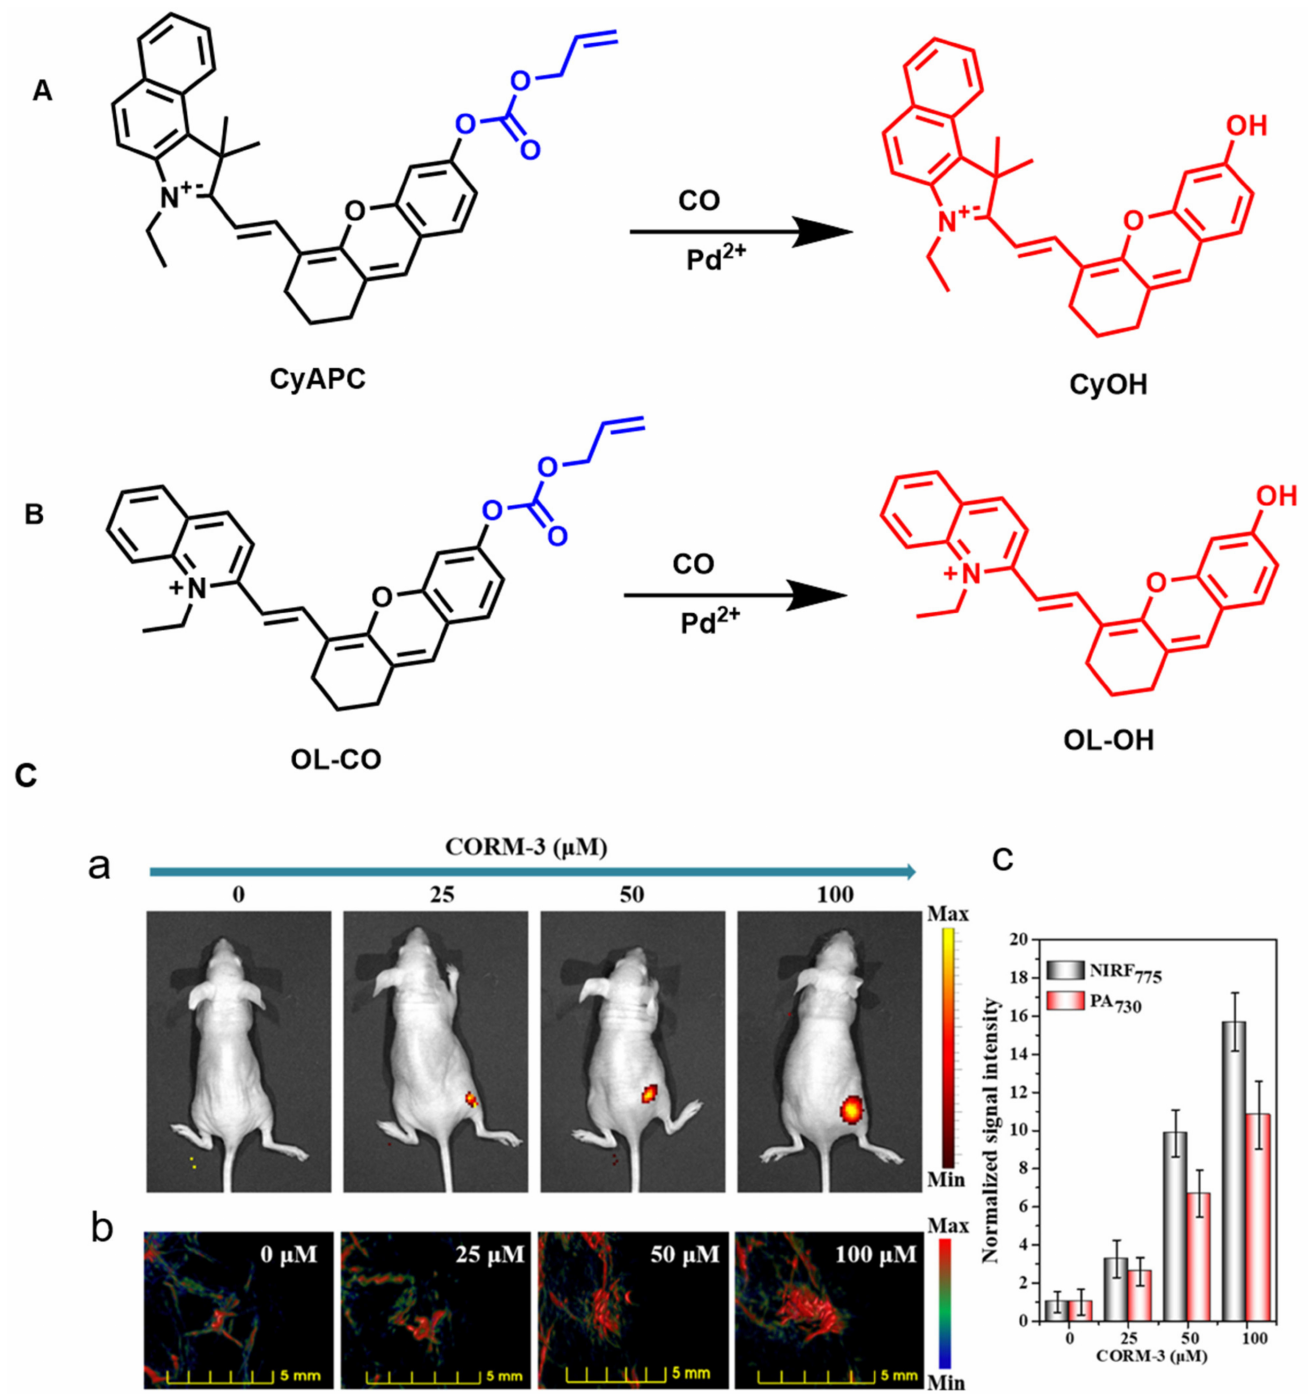
Figure 15. The response mechanisms and chemical structures ( A ) CyAPC and ( B ) OL-CO of fluores- cent probes for CO. ( C ) In vivo imaging of CO in living mice. ( a ) Fluorescent imaging and ( b ) PA730 imaging of living mice treated with the probe system (QL-CO + PdCl 2 , 20 µ M each) and various concentrations of CORM-3 (0, 25, 50, and 100 µ M) in mice. ( c ) Normalized NIRF775 and PA730 signal intensity values from ( a , b ). Reproduced with permission from Ref. [88]. Copyright (2022) American Chemical